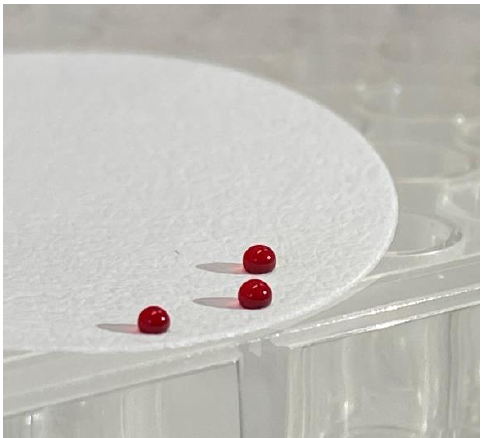
Figure 3. A 2 µL blood drop deposed on a PTFE filter; the drop remained spherical even after drying.